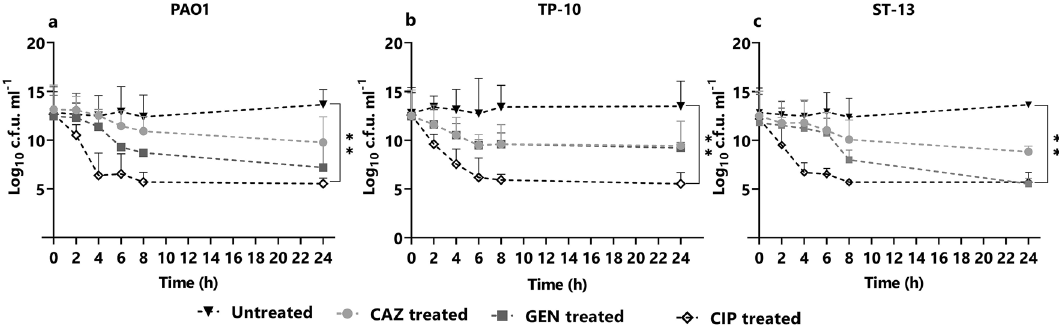
Figure 1. Planktonic time-kill curve assay. The planktonic stage of P. aeruginosa: ( a ) POA1, ( b ) TP-10, and ( c ) ST-13 were grown in LB and treated with CAZ, GEN, CIP at 5× MIC. At t = 2, 4, 6 8, and 24 h cells were plated for the viable count. Without treatment was used as a control. CAZ: ceftazidime; GEN: gentamicin, and CIP: ciprofloxacin. Statistical analysis was performed using one-way ANOVA, which was * P < 0.05, ** P <